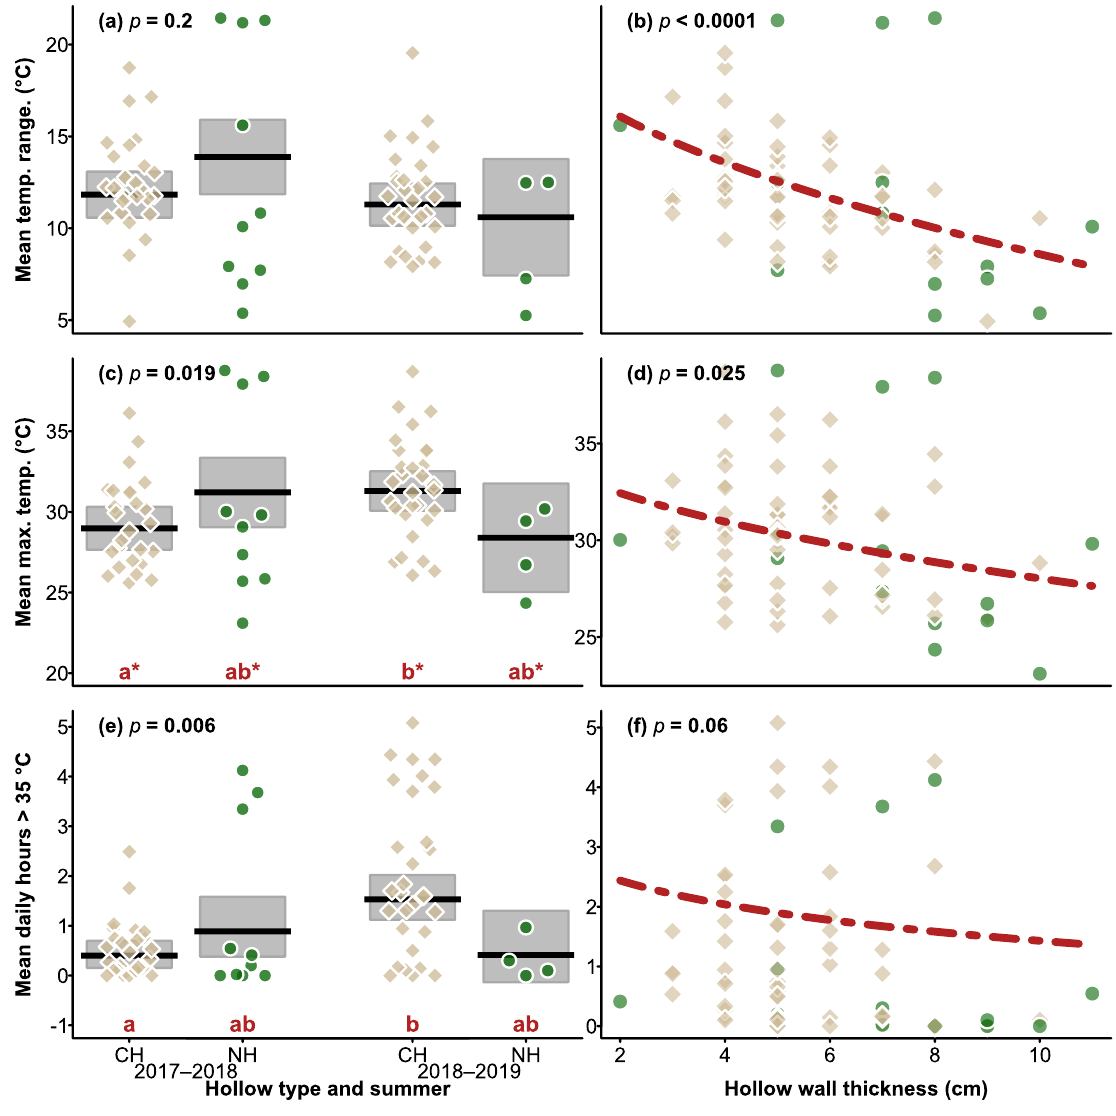
Figure 3. Plots of daily mean temperature range ( a , b ), mean maximum temperature ( c , d ) and hours over 35 ◦ C ( e , f ), over the two summers by hollow type (CH = chainsaw-carved hollow, NH = natural hollow) and summer (left column), and the responses relationship with wall thickness (right column). At the top of the plots showing hollow types × summer the p value of hollow type × summer interaction term is shown, and the significance of the effect of wall thickness is shown in the right column of the plots. For ( c , e ), the pattern of differences among the groups is indicated by the red letters on the x-axis, with the asterisk indicating statistically significant differences. In ( c ), no significant patterns emerged after correction for multiple comparisons, so results presented here are shown without correction to indicate which groups created the significant interaction effect. In the left column, means are indicated by black lines, shaded areas the 95% CI, and in the right column the broken red line indicates the relationship between hollow wall thickness, averaged across the categorical factors in the analysis, and a given response. Brown squares and green circles indicate mean values for CHs and NHs respectively within (left column) or across (right column) summers.